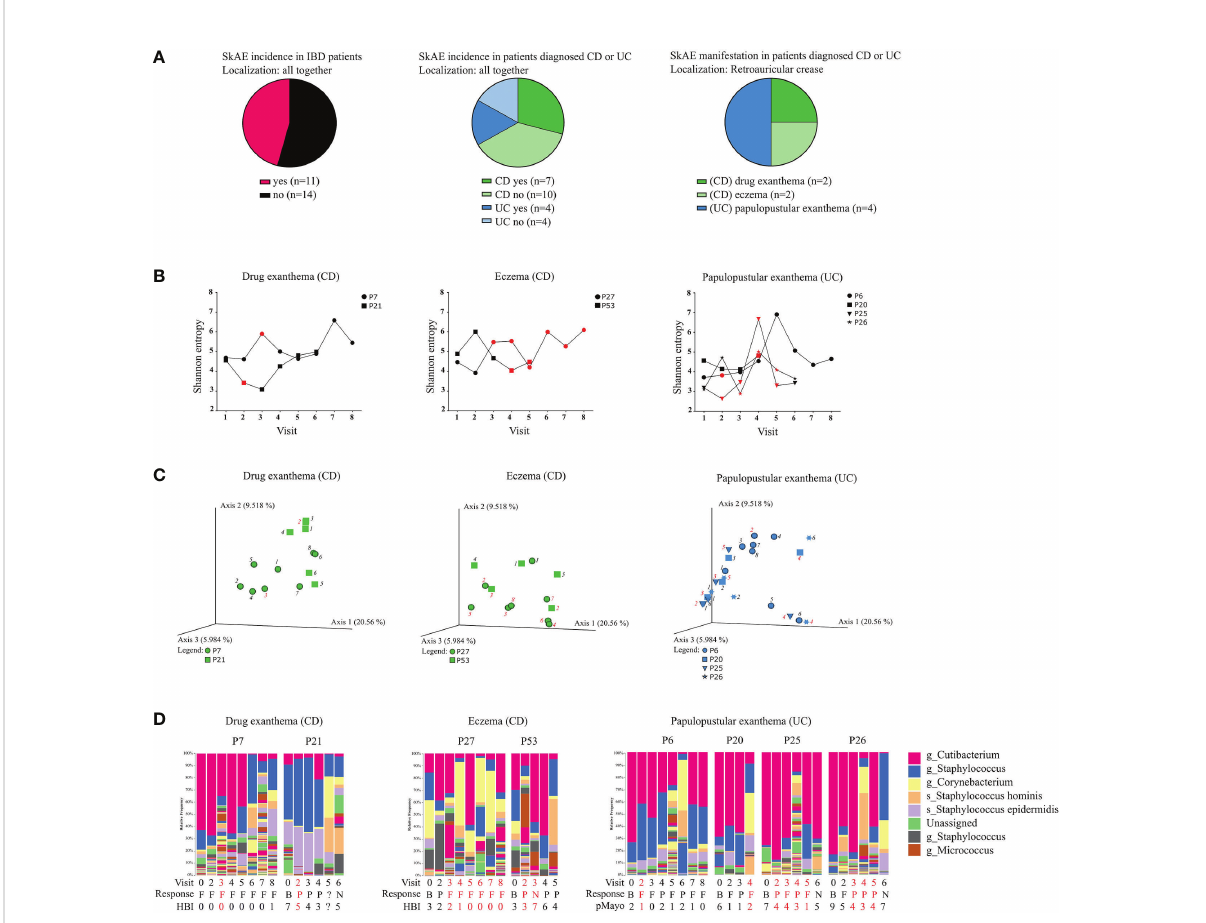
FIGURE 3 Characteristics of the IBD patients suffering from SkAE and their microbiota of retroauricular crease. (A) Pie charts showing patient ’ s distribution into groups. (B) Timeline of Shannon diversity changes in patients suffering from SkAE. The particular time of SkAE manifestation is color-coded in red. Graphs show a shift of Shannon entropy in particular patient ’ s visits. (C) Principal coordinate analysis of the Bray-Curtis distance between samples from patients with SkAE. All samples from one patient are represented by the same symbol, and the order of sampling is indicated by a label in italics, i.e., 1 is the fi rst sampling. SkAE manifestation is color-coded in red. Groups were compared by PERMANOVA. (D) Relative abundances of the most abundant taxa of skin microbiota at the genus and species level in patients with SkAE. Visit number, response to treatment, and the disease index for CD (HBI) or UC (pMayo) are shown. P7, P21, P27, P53, P6, P20, P25, and P26 represent the patient ’ s code designations. CD, Crohn ’ s disease; UC, ulcerative colitis. Response: B, baseline; P, partial; F, full; N, no response. HBI, Harvey-Bradshaw index. pMayo, partial Mayo